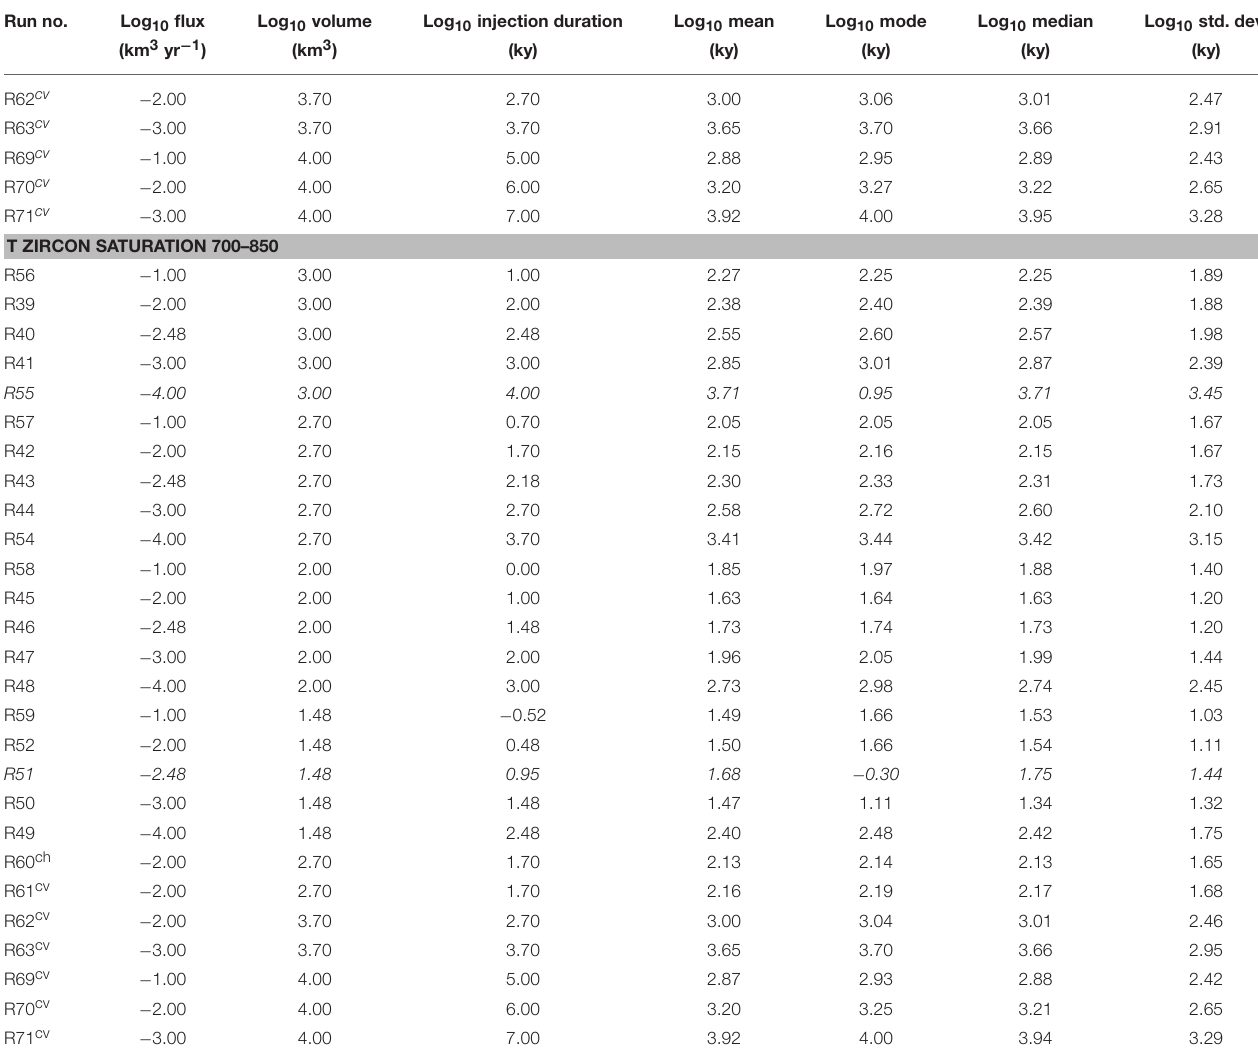
Figure 7 , where the red circle represents the mode, median, and standard deviation for the distribution shown in panel